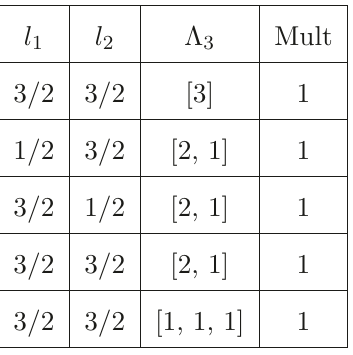
Table 7 . Results for n = 3 fields and k = 3 derivatives.